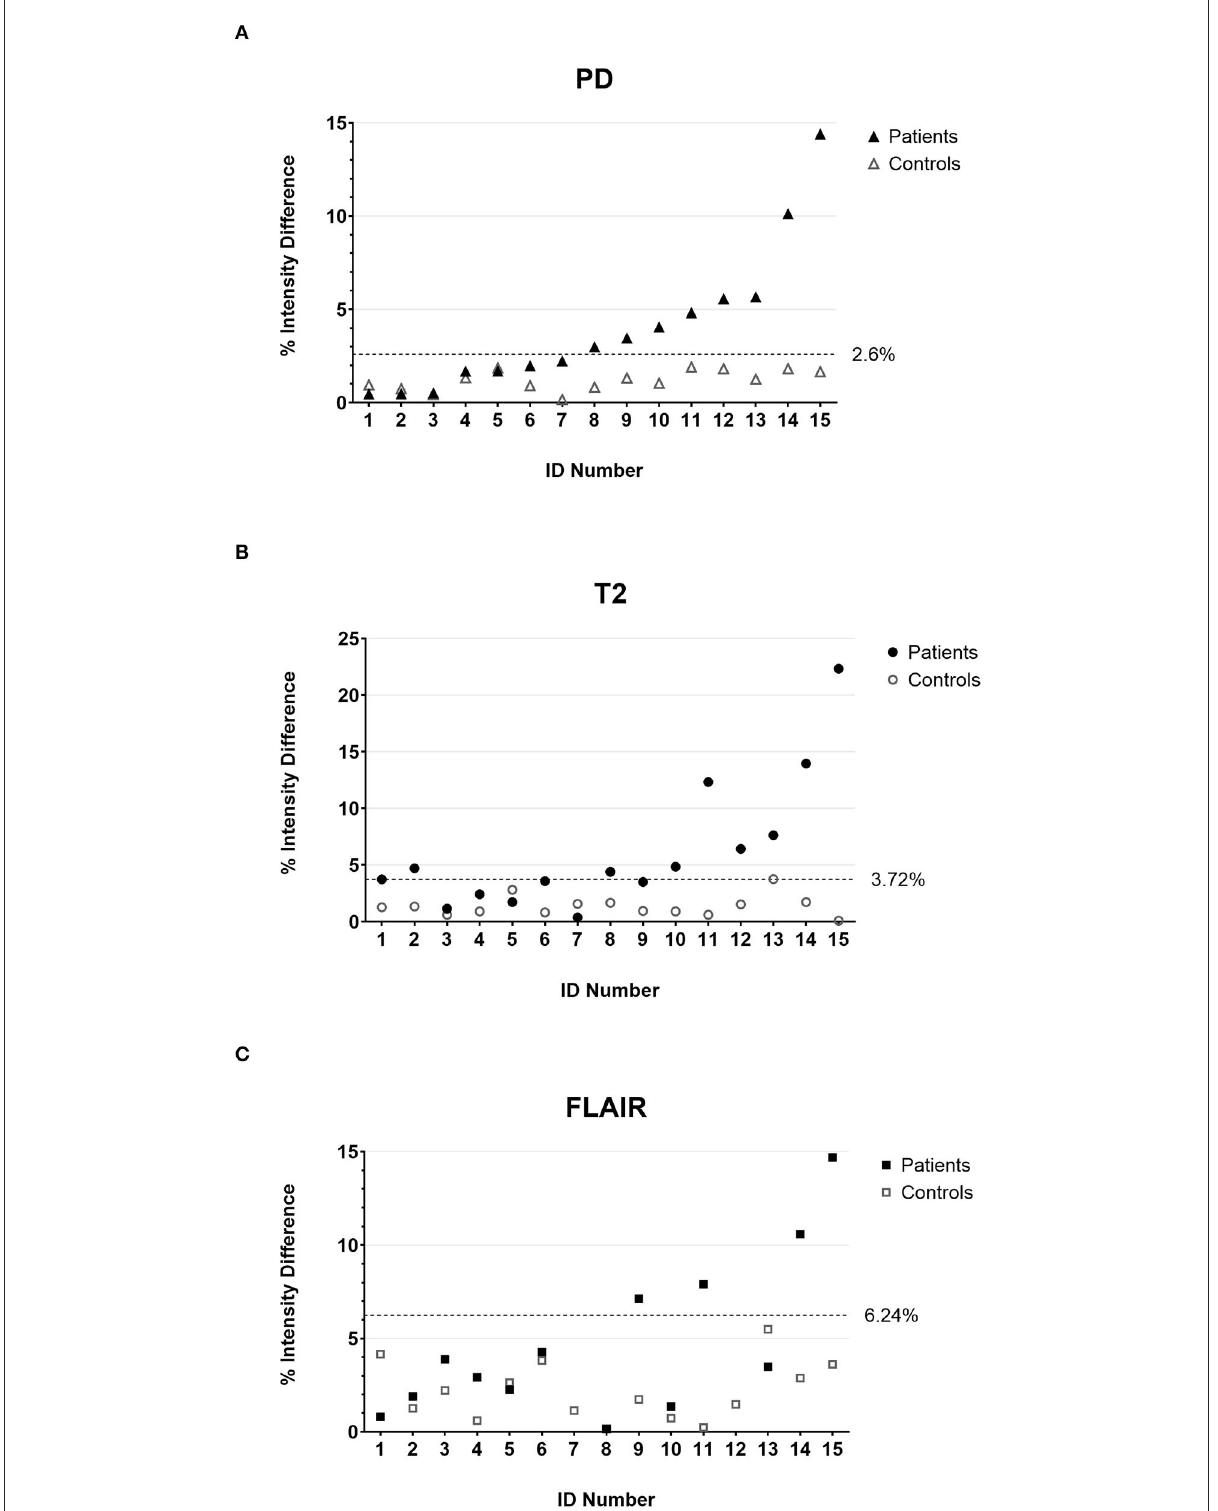
FIGURE2 The percentage intensity differences between the two anterior quadrants of the medulla oblongata for all individual patients (filled marks) and controls (empty marks) calculated on PD-w (A) , T2-w (B) , and FLAIR (C) . The dotted lines indicate the threshold below that 99% of the